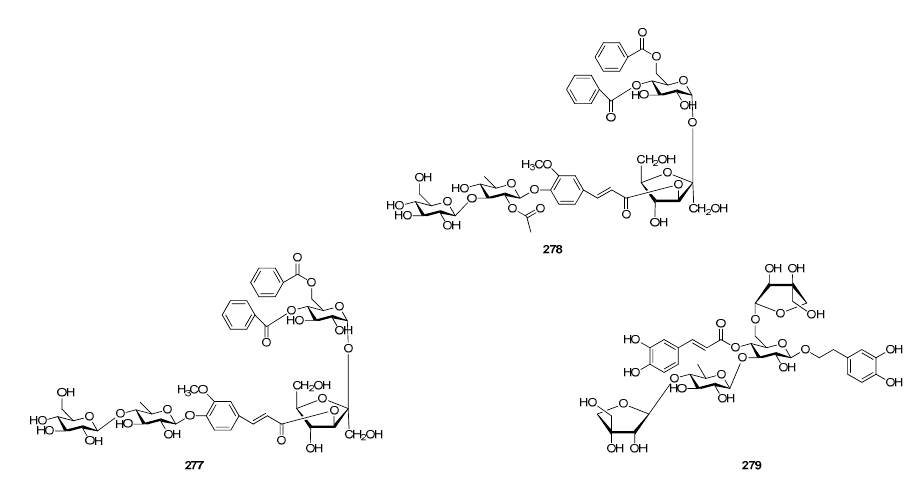
Figure 59. Structure of compound 276 .